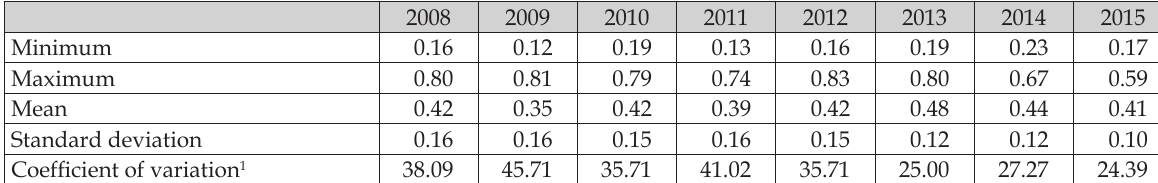
Table 3. Descriptive statistics of SSRR index for Austria, 2008–2015.